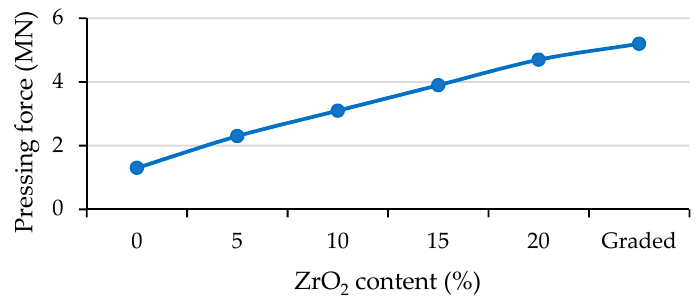
Figure 3. Compressive forces required for different ZrO 2 contents to achieve full density.